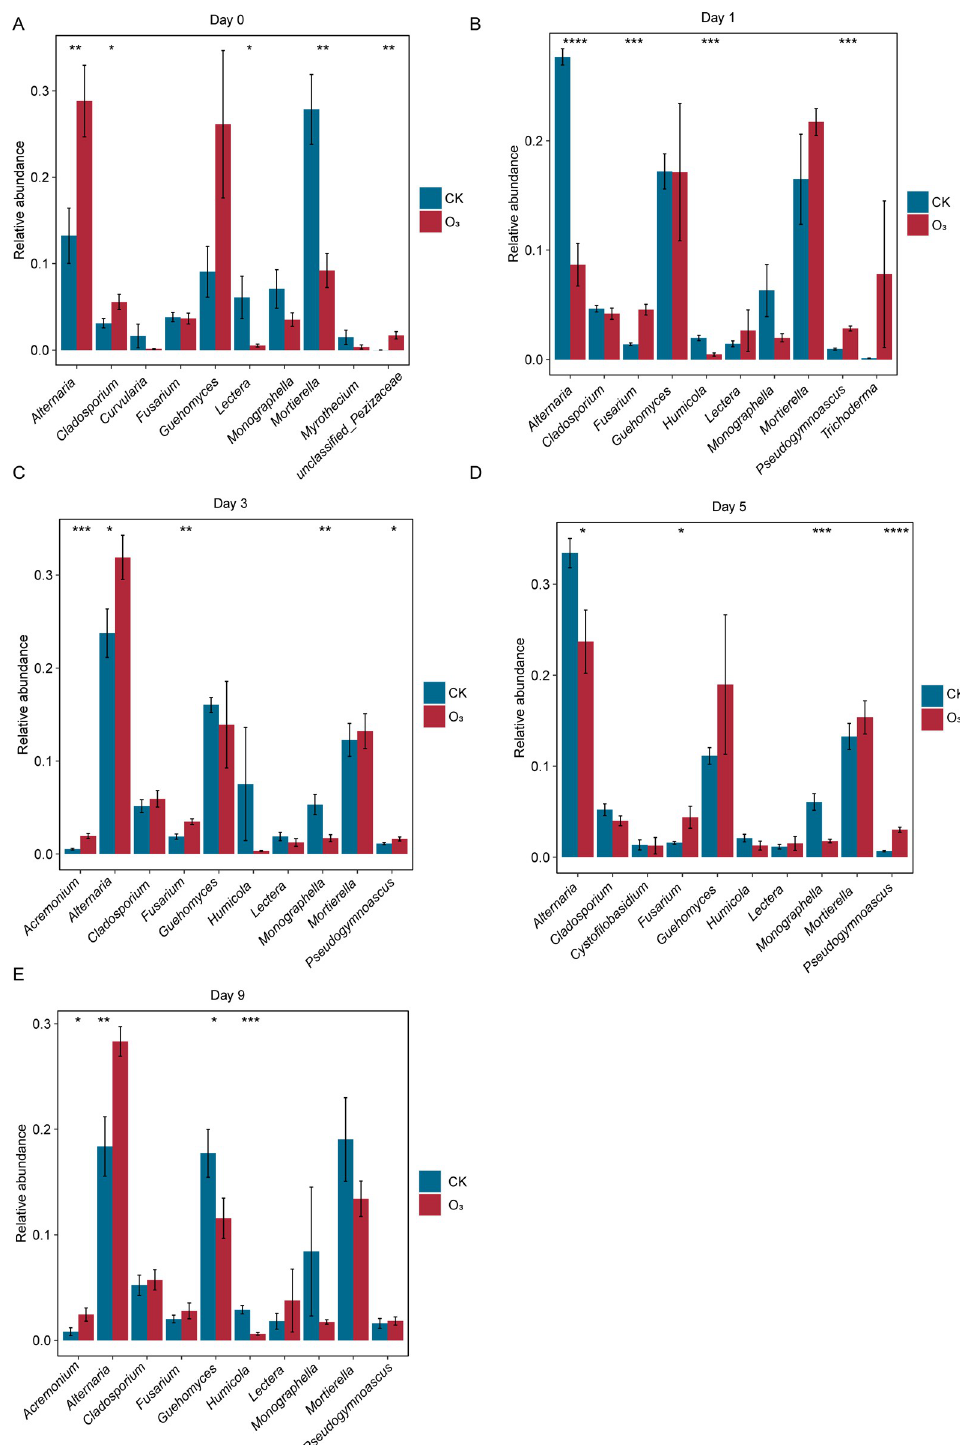
Fig 3. Changes of microbial communities with top 10 genus abundance in soil. (A-E) Changes of microbial communities at 0, 1, 3, 5 and 9 days. Statistical significance: � p < 0.05, �� p < 0.01, ��� p < 0.001, ���� p < 0.0001.